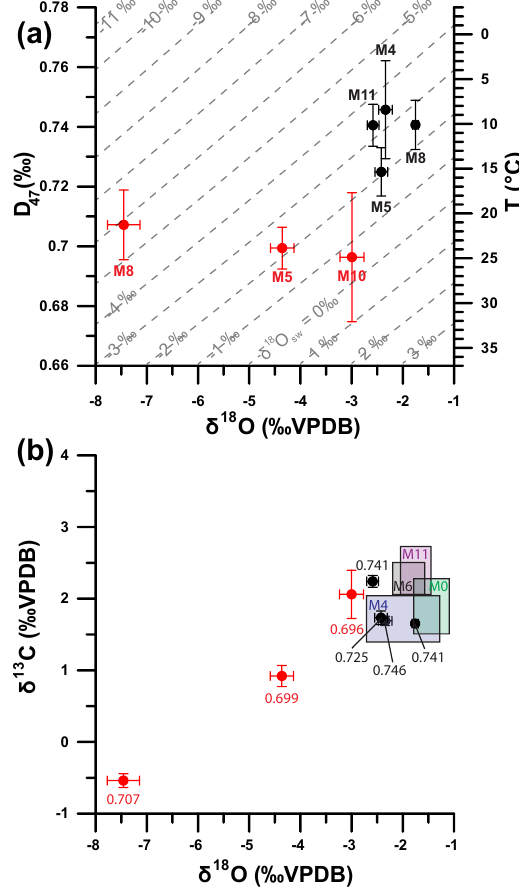
Figure 7. Cross plots of clumped isotope results. (a) (cid:49) 47 vs. δ 18 O from clumped isotope measurements on all seven shells. Red dots and error bars represent measurements of samples from the ventral margin of the shells, while black dots and error bars indicate results from dense, foliated calcite from the hinge of the shells. Dashed lines illustrate the δ 18 O values of seawater that correspond to the combination of (cid:49) 47 and δ 18 O values in the graph. (b) δ 13 C vs. δ 18 O from clumped isotope measurements on all shells. Symbols as in (a) . Numbers next to the dots indicate (cid:49) 47 values measured in the same samples. Coloured rectangles indicate the range of pristine stable isotope values measured in high-resolution transects through the hinges of shells M0, M4, M6 and